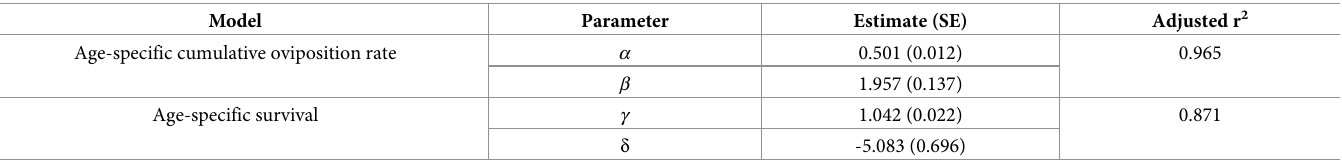
Table 4. Estimated parameters in age-specific cumulative oviposition rate and survival